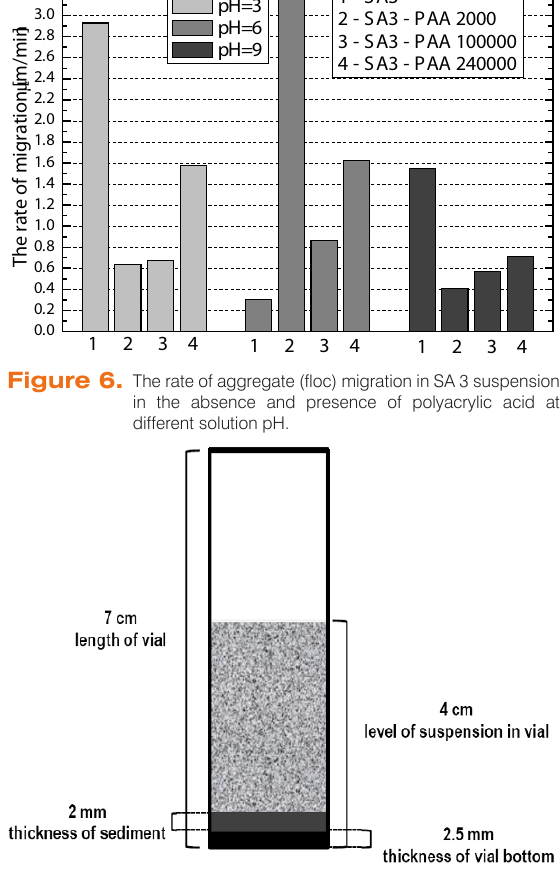
Figure 7. The schematic presentation of measuring vial containing suspension with marked sediment